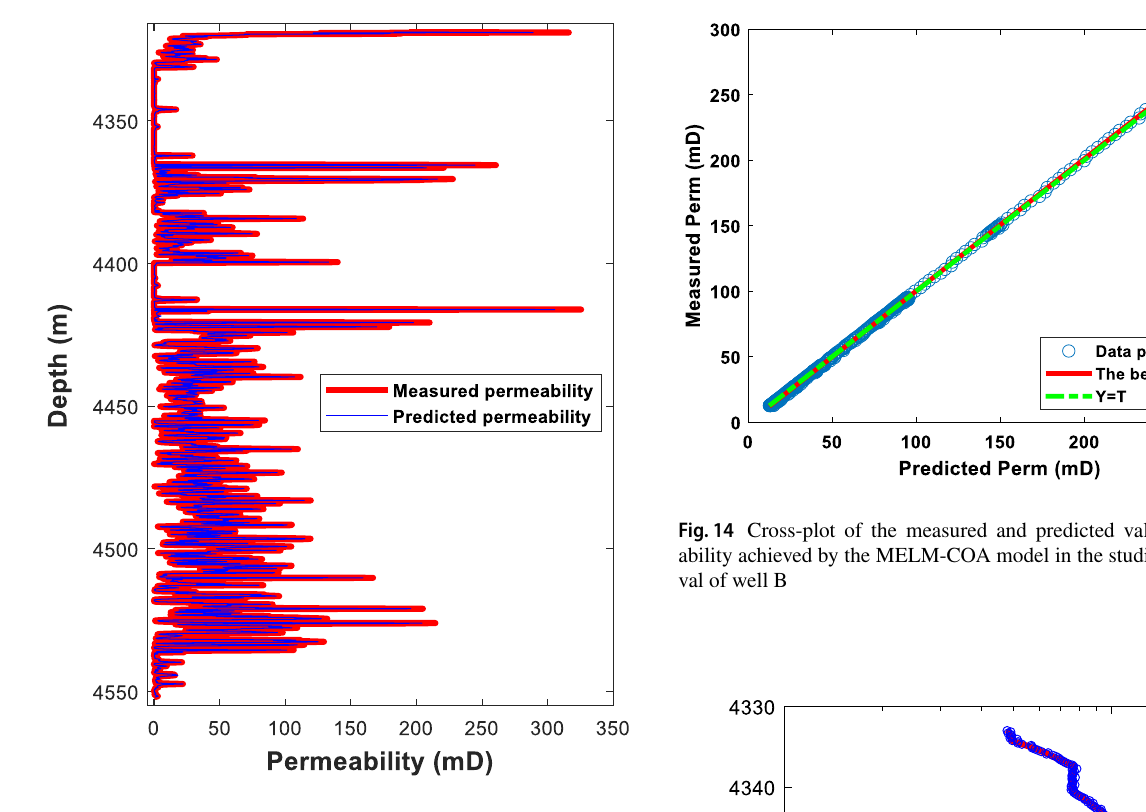
Fig. 13 Comparison of measured and predicted permeability for the complete dataset (with outliers) using developed MELM-COA model based on without outlier data in the studied depth range of well A